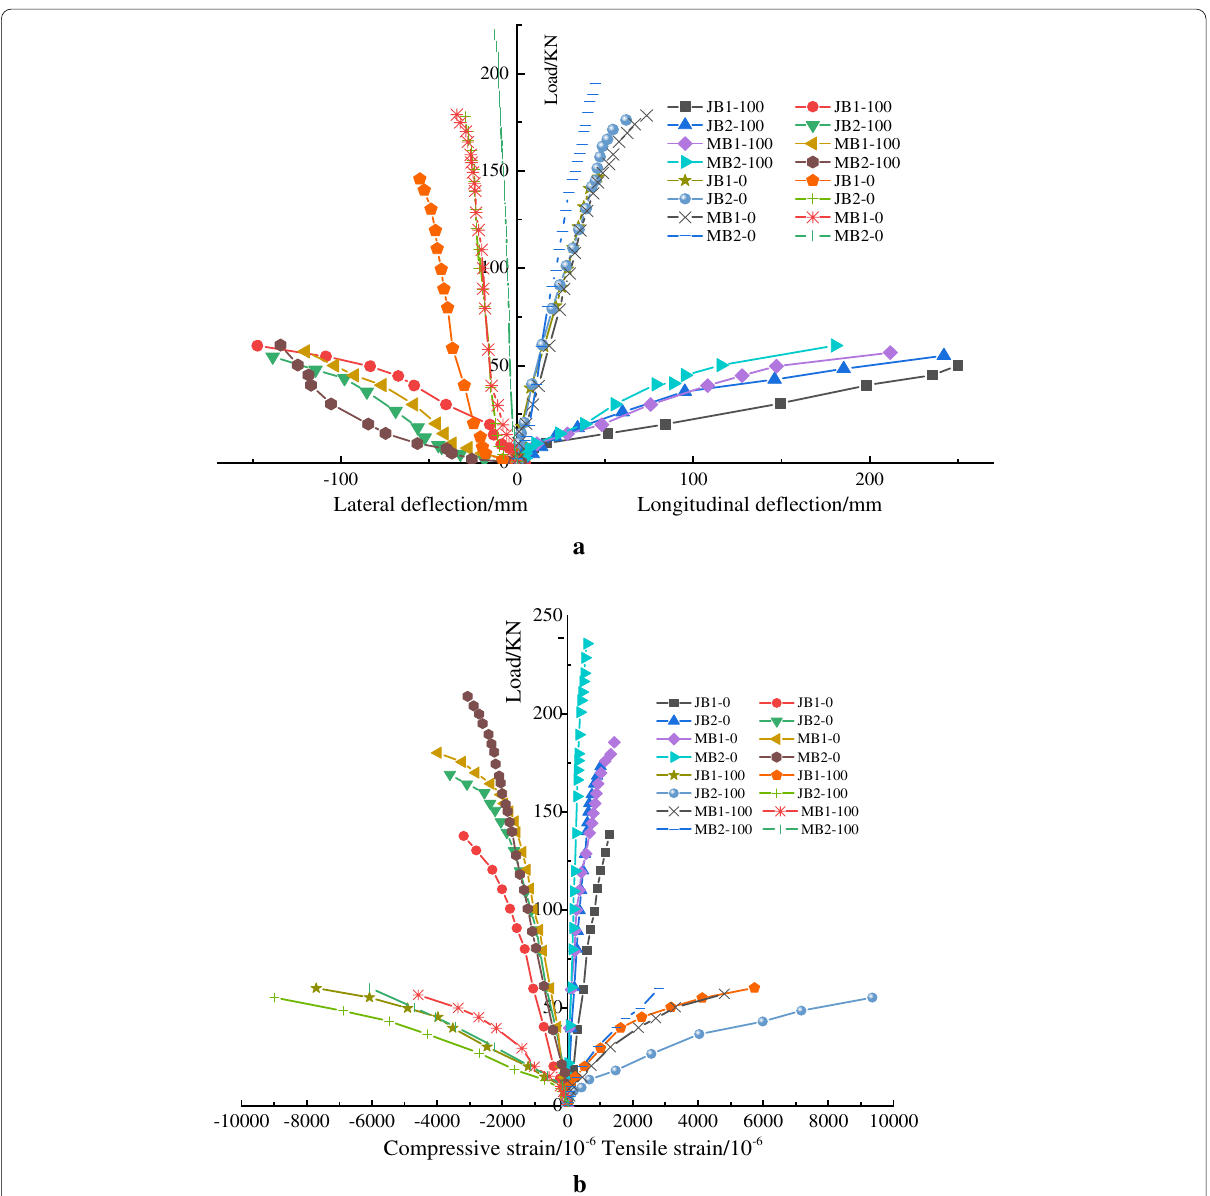
Fig. 9 Load—strain curve ( a ) and load–displacement curve ( b ) of reinforced column with an eccentricity of 100 mm under